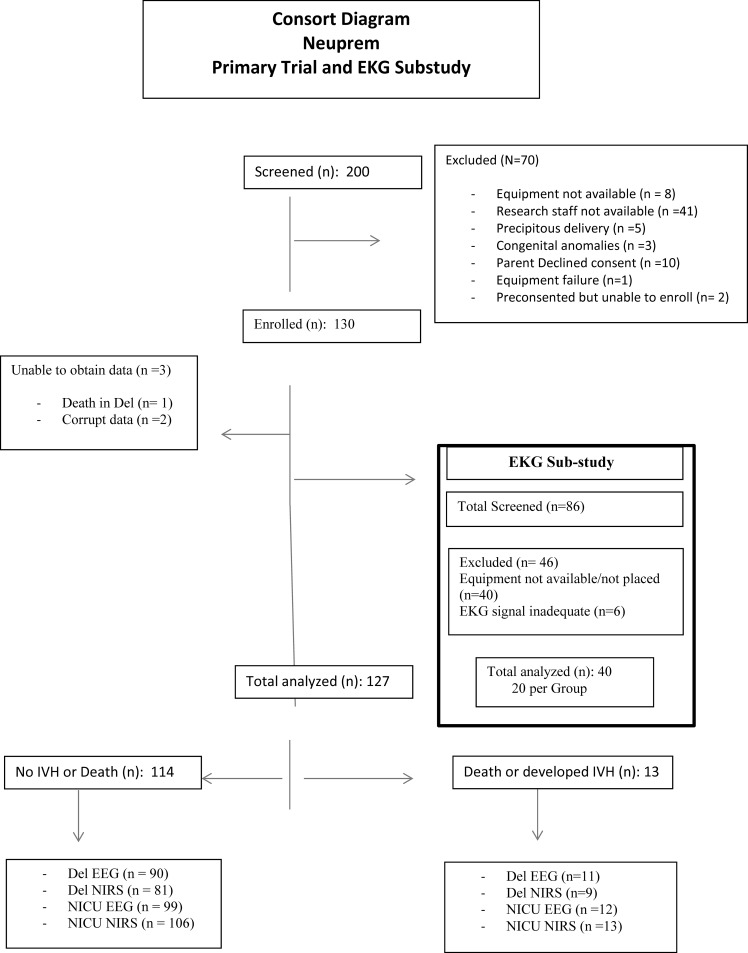
Consort diagram.